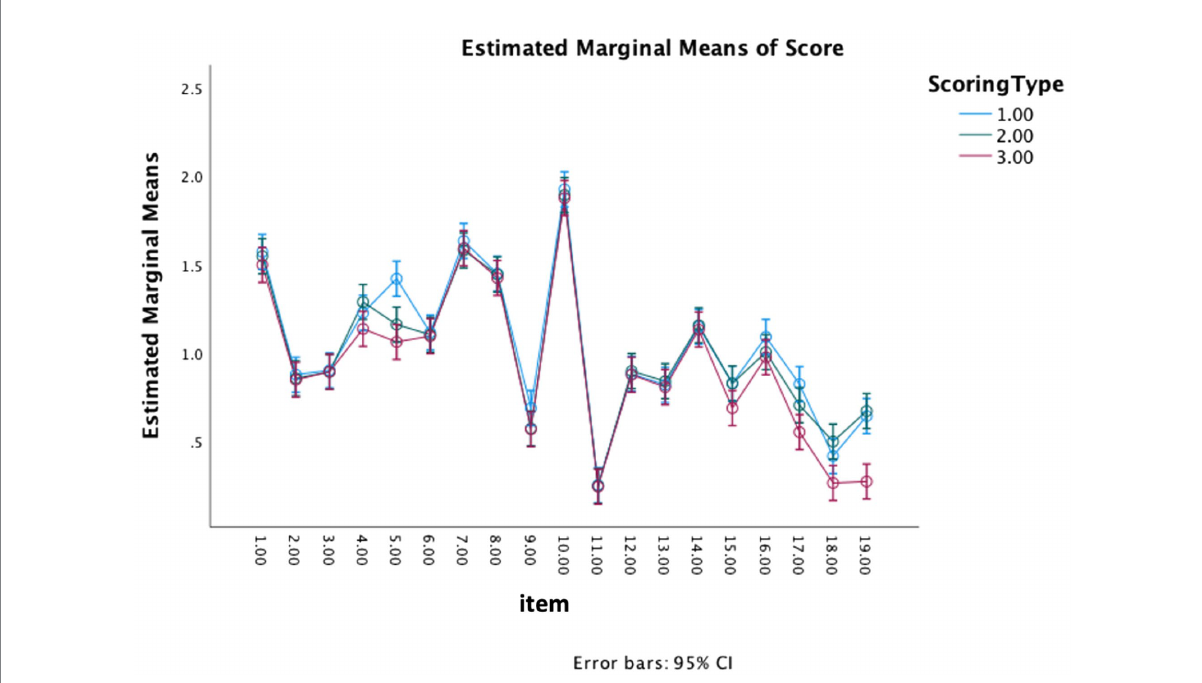
FIGURE 2 Estimated marginal means and the corresponding confidence intervals for each scoring approach for each item. Scoring type: 1—human holistic; 2—machine analytic; 3—machine holistic. Itemnew: 1–5 is S1–S5 (sugar testlet); 6–11 is B1–B6 (Bacteria testlet); 12–19 is G1–G8 (Gases